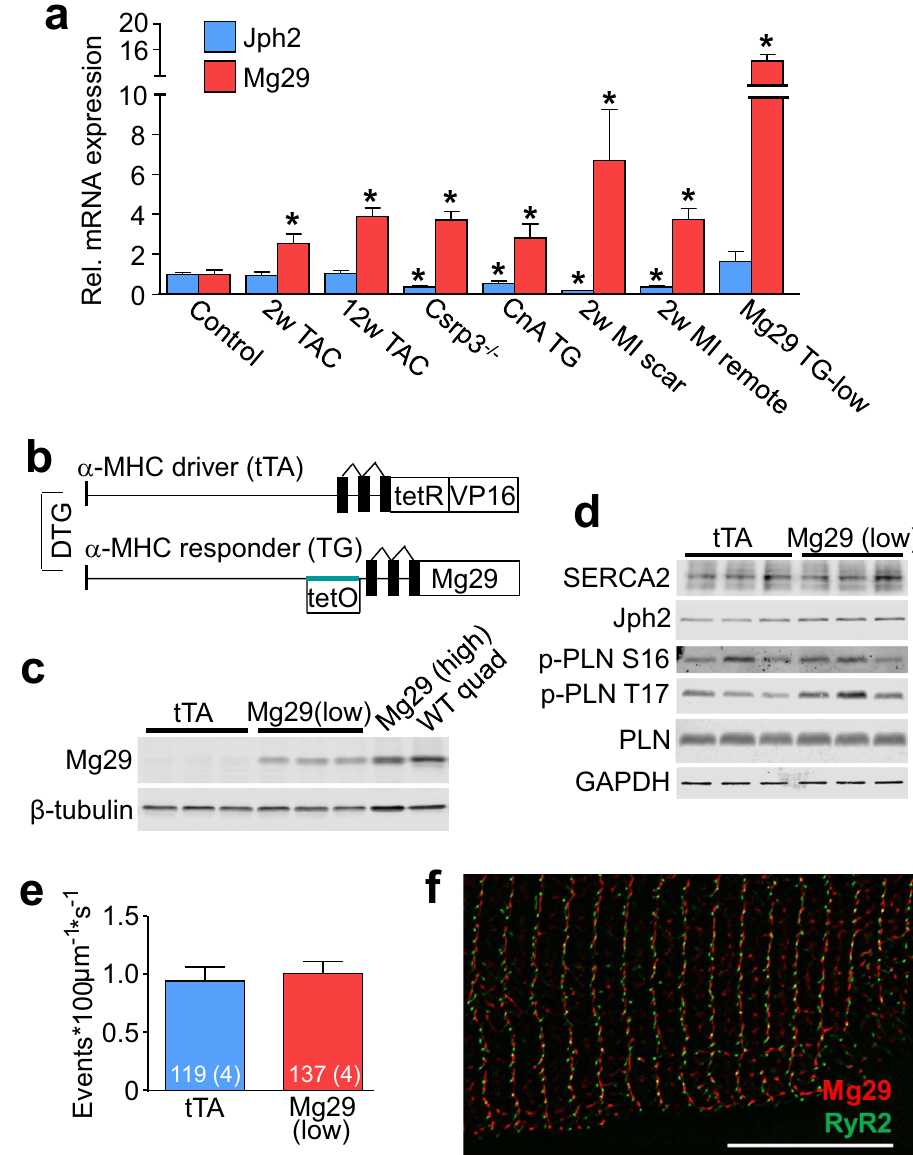
Figure 1. Mg29 mRNA is induced during heart failure. ( a ) Quantitative PCR demonstrating increased expression of Mg29 mRNA (red) and reduced expression of Jph2 mRNA (blue) in hearts of both Csrp3 − / − mice lacking MLP and calcineurin A (CnA) transgenic mice, as well as both the scar and remote regions of hearts after two weeks of myocardial infarction (MI). Hearts subjected to either 2 or 12 weeks of transverse aortic constriction (TAC) surgery showed induction of Mg29 but no change in Jph2 levels. Mg29 Low transgenic hearts (described below) showed approximately 14-fold induction of Mg29 message compared to WT control hearts. Hearts from 6 control mice, 6 two-week TAC mice, 10 twelve-week TAC mice, 5 Csrp3 − / − mice, 6 CnA transgenic mice, 5 two-week MI mice, and 4 Mg29 Low transgenic mice were utilized in this experiment. * P < 0.05 compared to expression in control mice. ( b ) Schematic representation of double transgenic (DTG) system used to express Mg29 in the mouse heart. ( c ) Immunoblot demonstrating expression of Mg29 protein in the DTG mouse heart (Mg29 High) at comparable levels to that seen in wild-type quadriceps muscle (WT Quad). Administration of DOX in the chow reduced Mg29 levels (Mg29 Low). Cropped western blots images are shown although the full-length gel files can be viewed in Supplemental Fig. 3. Photoshop was used to process the images, although they were not manipulated to alter the data. ( d ) Immunoblots of Ca 2 + handling proteins in DTG hearts expressing Mg29 or tTA-expressing control hearts. Phospholamban (PLN) and its phosphorylated forms at S16 and T17 were also unchanged. Cropped western blots images are shown although the full-length gel files can be viewed in Supplemental Fig. 3. Photoshop was used to process the images, although they were not manipulated to alter the data. ( e ) Ca 2 + spark frequency measured in myocytes isolated from DTG hearts expressing Mg29 or tTA-expressing control hearts. Number of myocytes and animals used are shown in the graph. ( f ) Super-resolution confocal microscopy of an isolated adult cardiomyocyte from a DTG heart showing that Mg29 (red) and RyR2 (green) are adjacent but not overlapping. Scale bar is 10 µ